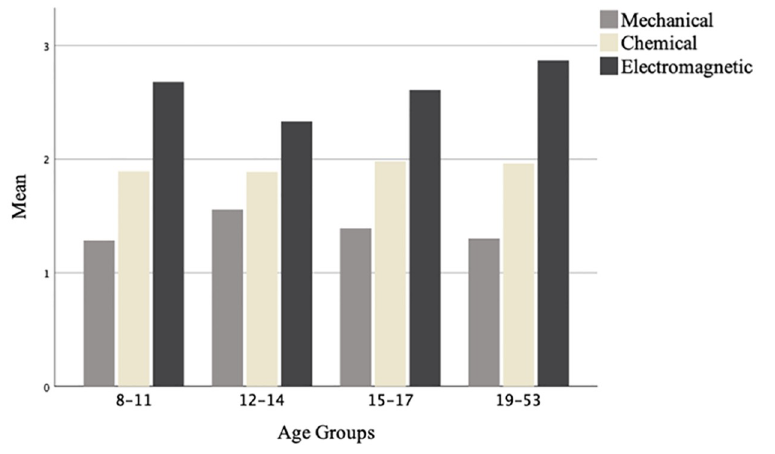
Fig 6. Participants’ choices across age